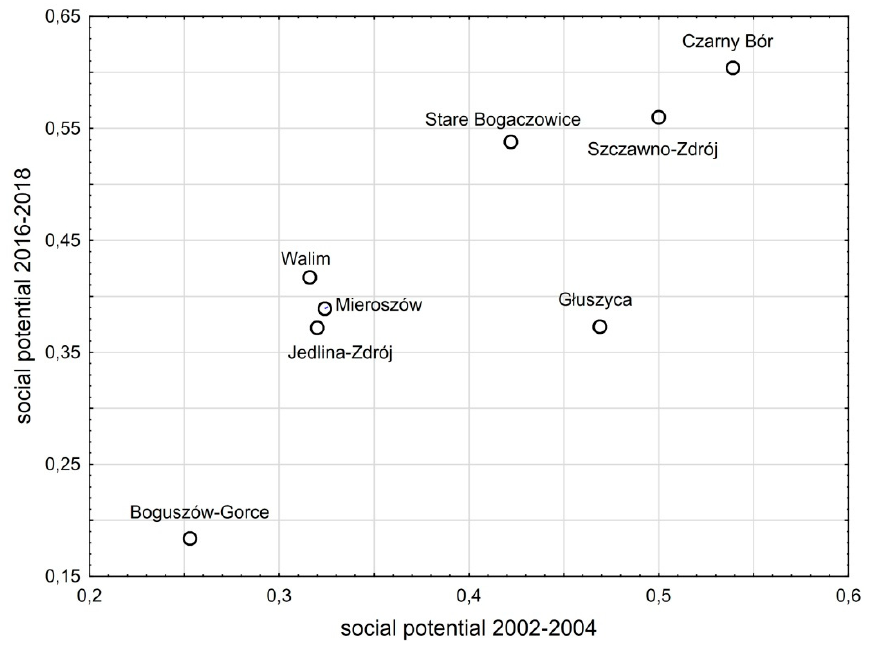
Figure 1. Scatter plot of social development potential in 2002–2004 vs. 2016–2018. Source: authors’ compilation based on bdl.stat.gov.pl (accessed on 30 October 2020) [32].